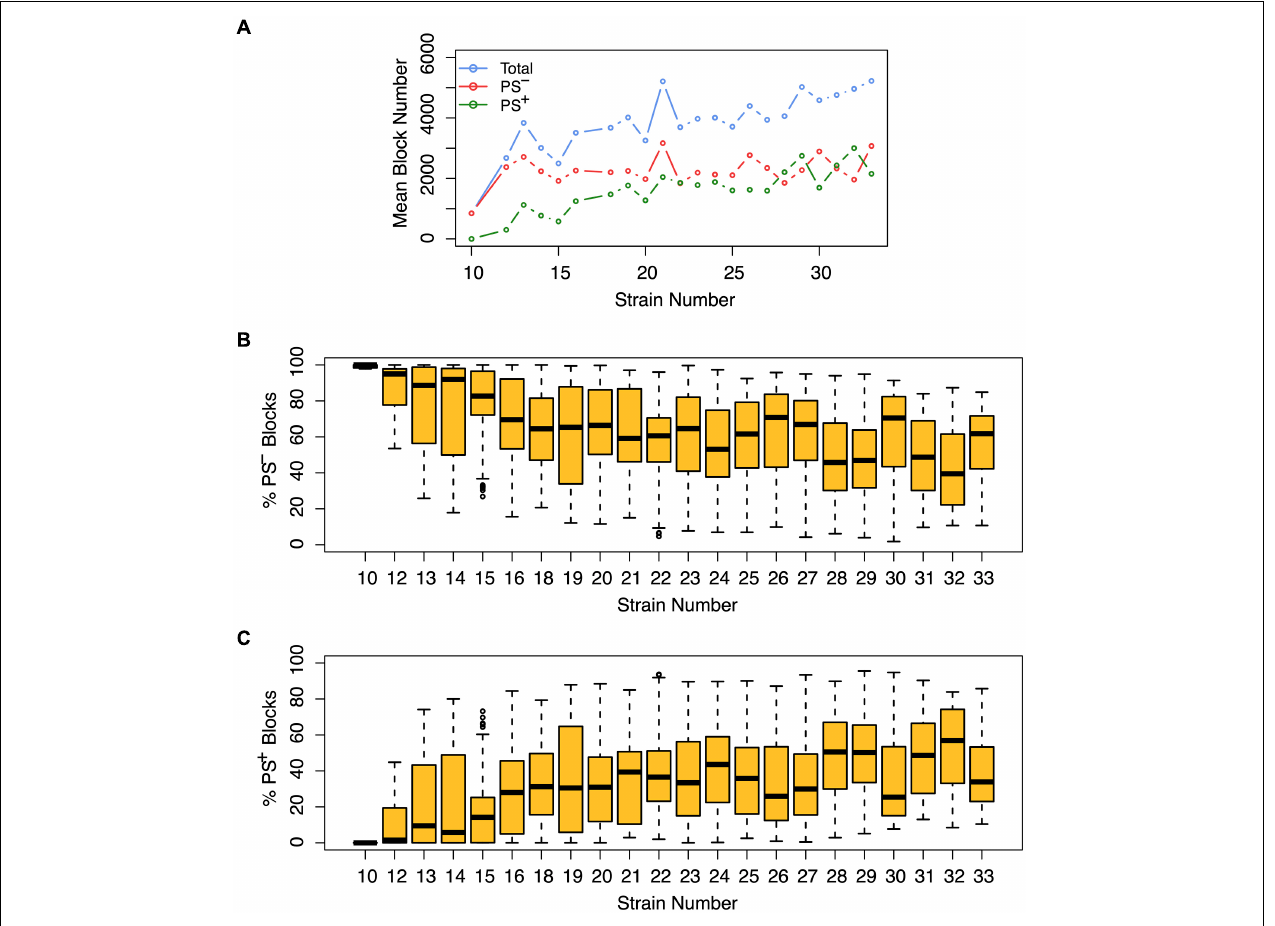
FIGURE 3 | The effect of population structure increases with the number of analyzed strains. Analysis of the total number of candidate haplotype blocks, the number of blocks with population structure (PS + ), and the number of PS-independent (PS - ) blocks are shown as a function of the number of analyzed strains. After 2435 MPD datasets were analyzed by HBCGM, the correlated blocks ( p HBCGM < 0 . 01) were analyzed by an association test to determine whether population structure had a significant influence on the strain groupings within the blocks. (A) The results were then graphed as a function of the number of mouse strains within each dataset (range 10 – 33). A blue circle represents the average of the total number of candidate blocks, and the mean number of PS - (red) and PS + blocks (green) are also shown in this graph. (B,C) The percentage of (B) PS - and (C) PS + blocks were then assessed for each dataset. The box plots indicate the 25th and 75th percentile, and the black bar indicates the median value. While the number of PS - blocks plateaued after 15 strains were analyzed, the number of PS + blocks increased in the datasets that analyzed an increased number of